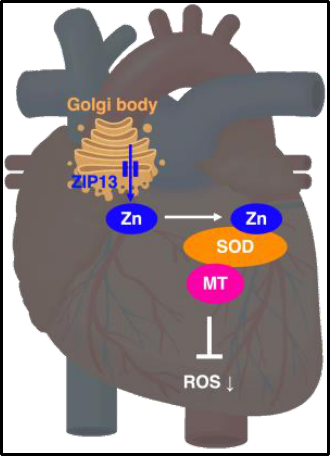
Figure 4. ZIP13 indicates the maintenance of cardiovascular homeostasis by resolving inflammation and stress response. ZIP13 plays a role in cardiovascular homeostasis by resolving inflammatory and stress responses. ZIP13 significantly affects cardiac physiology; therefore, it is a potential therapeutic target for CVD.